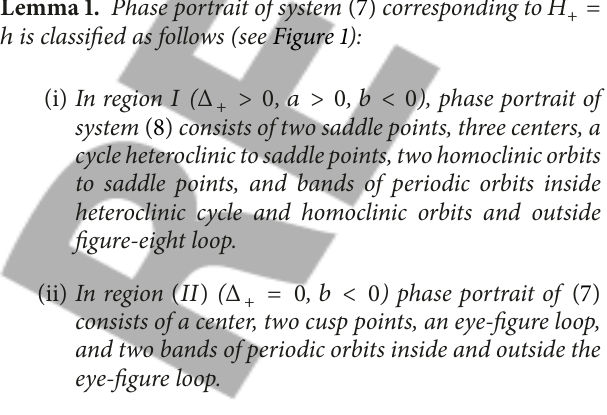
a maximum and V = ±√(−𝑏 + √Δ + )/2 are minimum